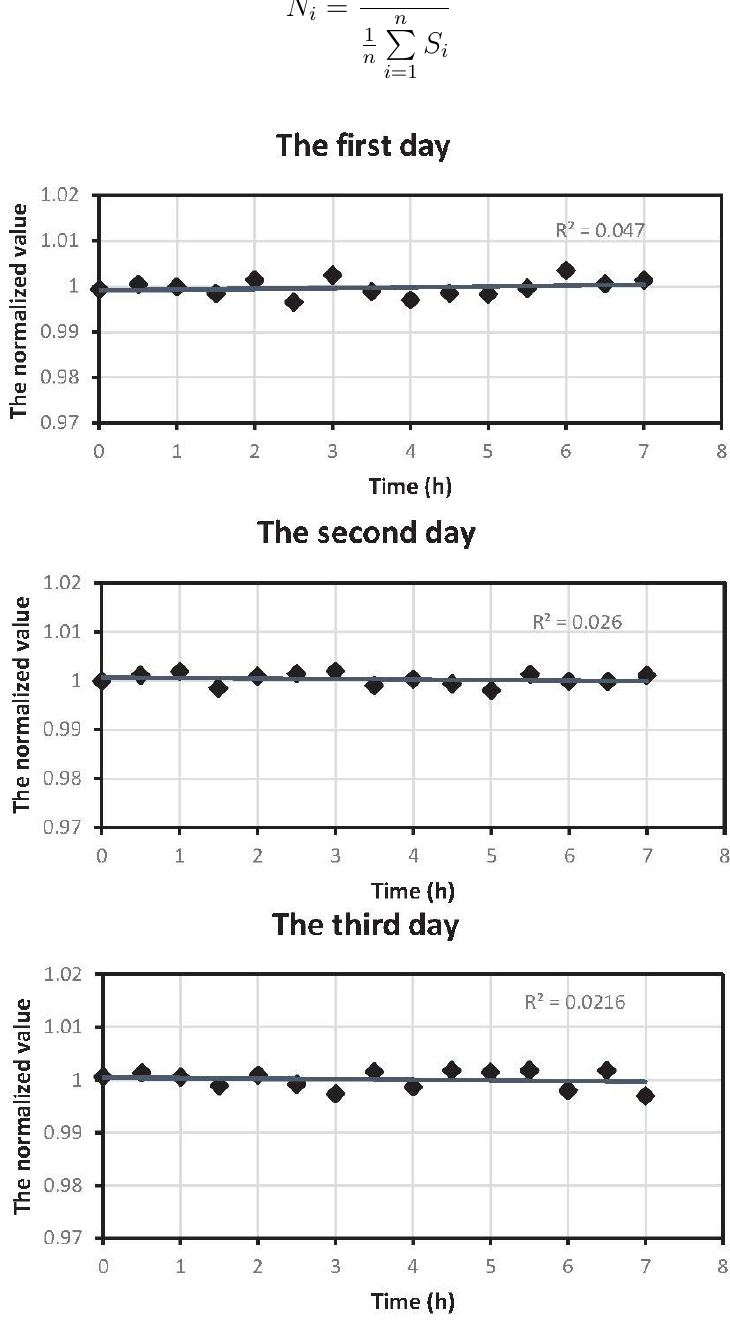
Figure 13. Stability test of the